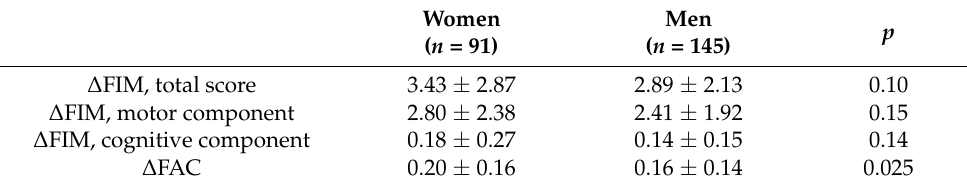
Table 3. Variations of outcome measures normalised for the number of RAGT sessions in the two